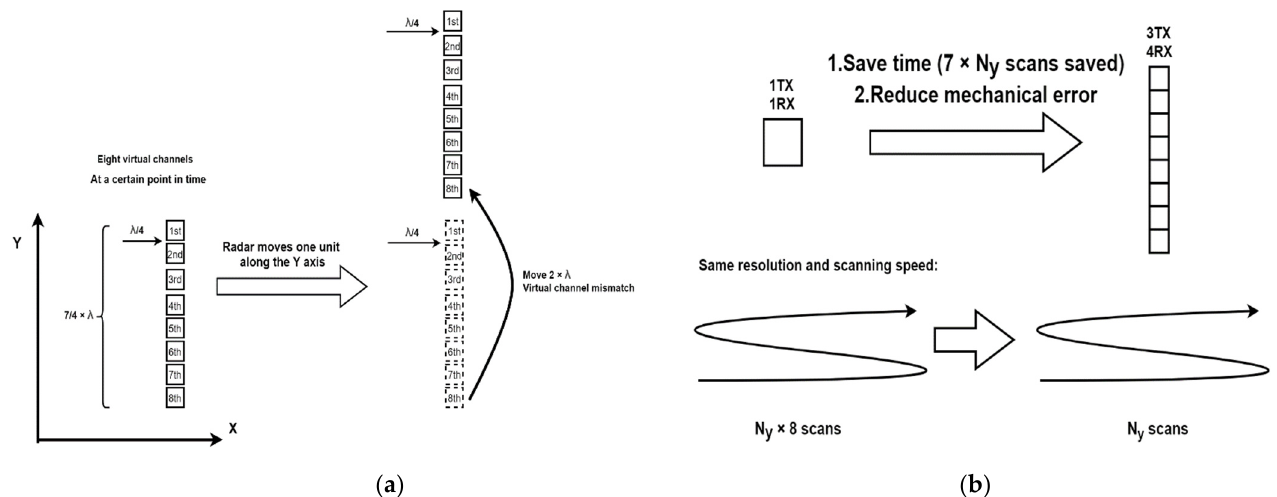
Figure 4. ( a ) Displacement map of virtual channel in Y-direction; ( b ) the antenna of single transmitter and single receiver is compared with that of multiple transmitter and multiple receiver.